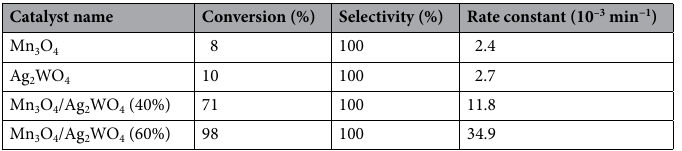
Table 1. Experimental results of photocatalytic hydrogenation of nitrophenol using the as-synthesized catalysts.